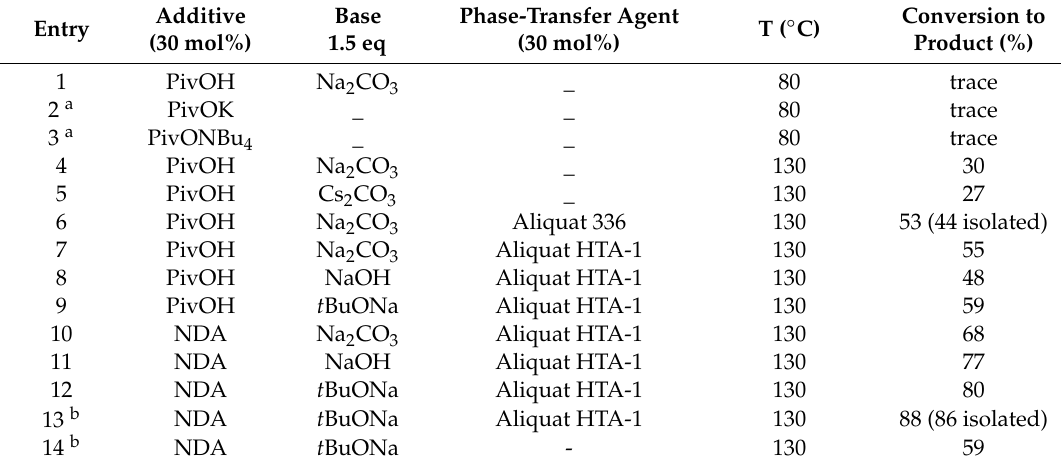
Table 1. Screening of suitable reaction conditions and formulation of the DHA coupling between 2-hexylthiophene and 4-bromoanisole in emulsion medium. All reactions were carried out in a pressure-tight 10 mL screw-cap glass tube under magnetic stirring at 1000 rpm for 24 h and at a nominal concentration for the reagents of 0.5 mol /